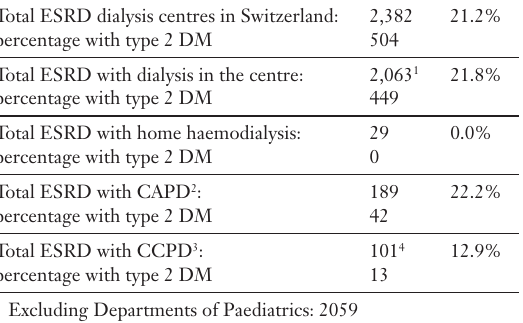
Dialysis centres in Switzerland: total ESRD, percentage of ESRD with type 2 DM and mode of therapy (assessed on 31 December 2001).